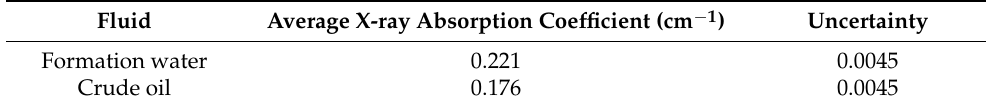
Table 7. Formation water and oil absorption coefficients and